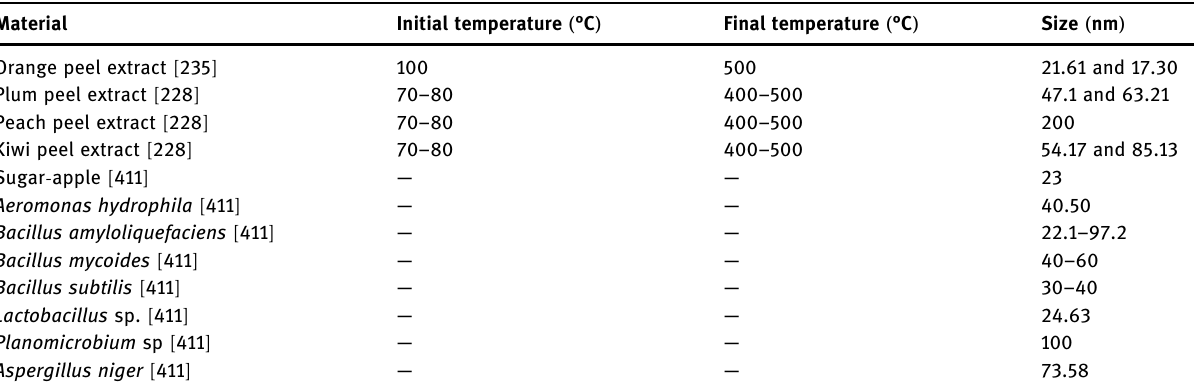
Table 8: Di ff erent synthetic biological methods, and corresponding properties of TiO 2 NPs Material